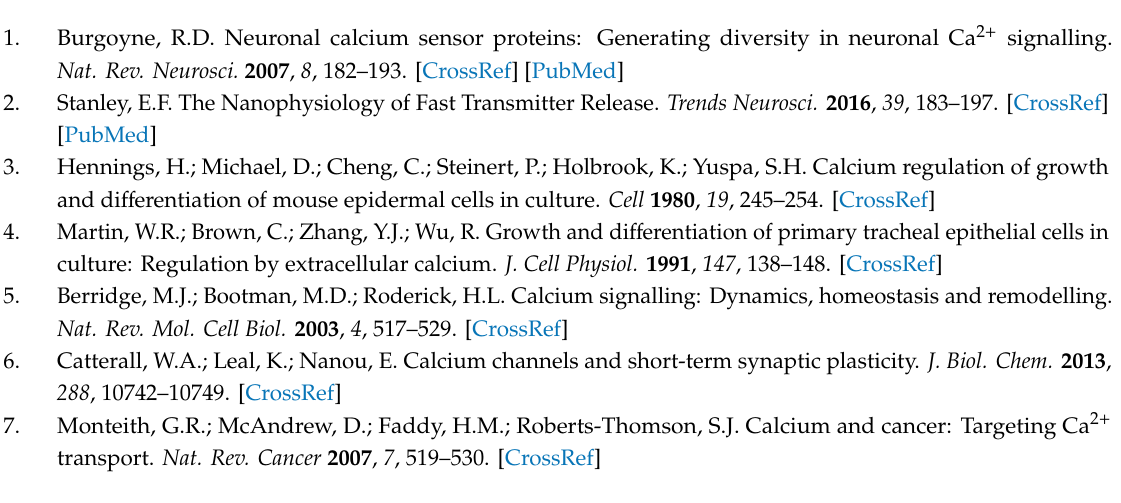
Figure S4: (A) A bleed-through in the filter setting GR shows the changes in time course plot of FRET / EGFP signal ratio of FRET-CFPYPet transfected cells. (B) No bleed-through is observed in the FRET / ECFP signal ratio of FRET-GFPRed transfected cells under the filter setting CY. FRET biosensors were transfected by high frequency ultrasound. Ultrasound was applied at t = 0 for 5–10 µ s, Supplementary Video 01: Video recording of Figure 4A. Two cells were transfected with FRETGFPRed. The cell on top was stimulated by high frequency ultrasound. Intensity of the video were not modified, Supplementary Video 02: Video recording of Figure 5. Three cells were transfected with FRETCFPYPet. The cell in the middle was stimulated by high frequency ultrasound three times. Intensity of the video were not